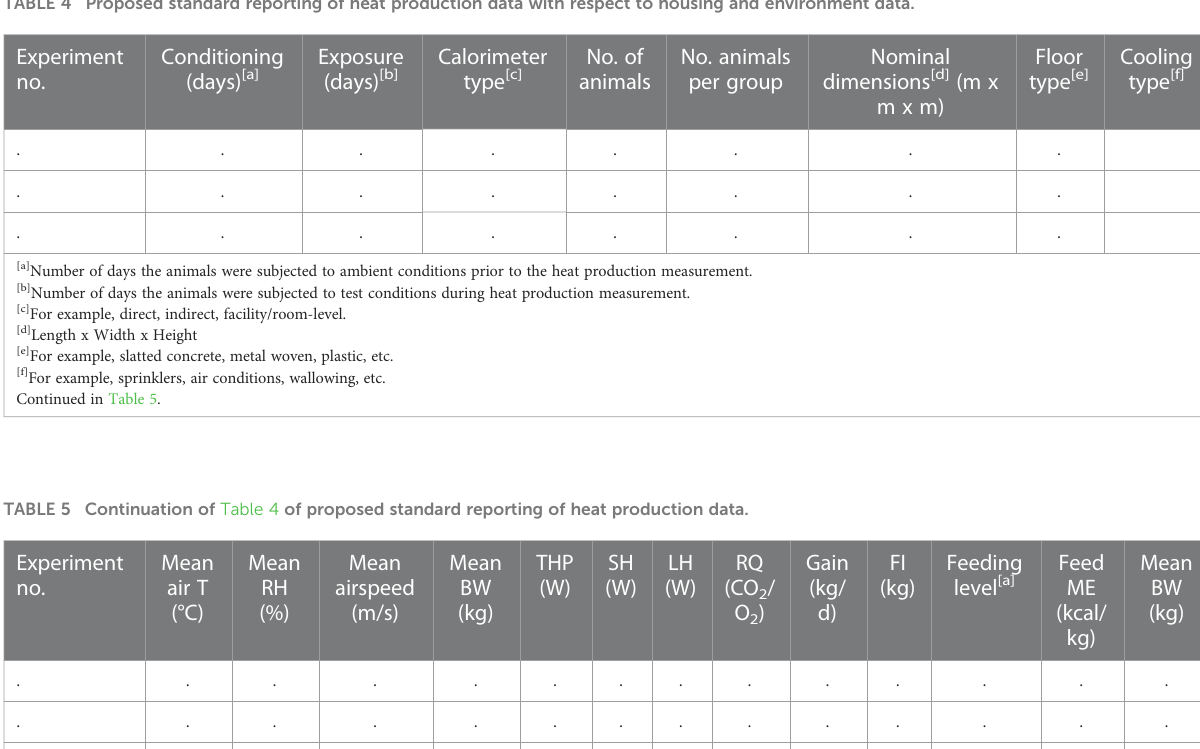
TABLE 4 Proposed standard reporting of heat production data with respect to housing and environment